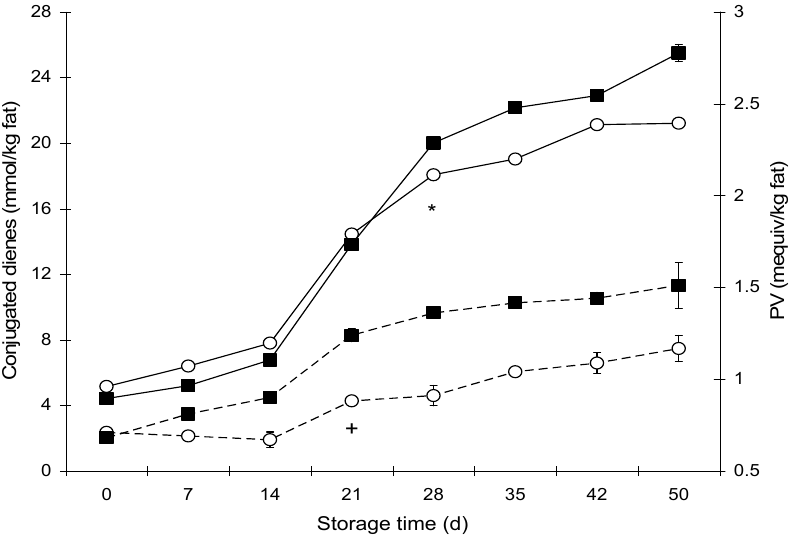
Figure 7. Level of conjugated dienes ( ― ) and peroxide value ( --- ) for control ( ■ ) and treatment ( ○ ) cream cheese stored for 50 days at 4 °C. * + shows time where scores significantly changed ( P < 0.05) between treatment and